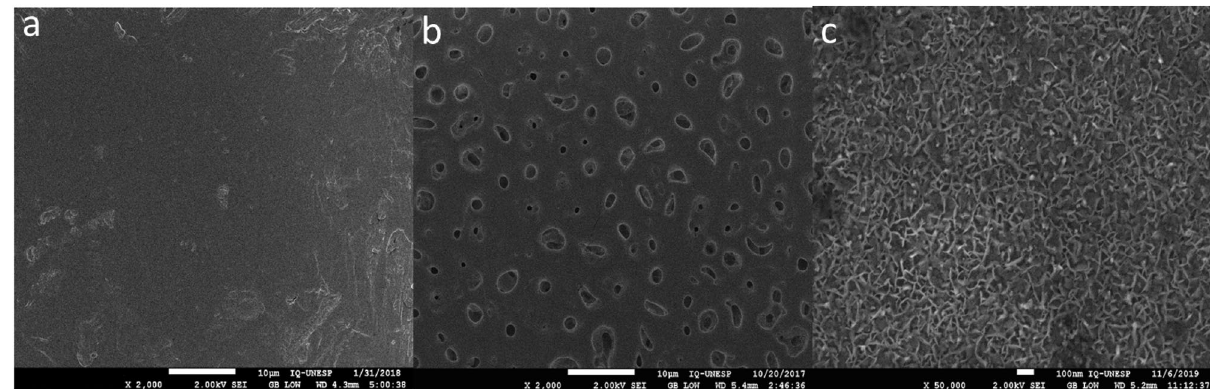
Fig. 1 Microscopy of study surfaces. a C group; b CaP group; c Mg